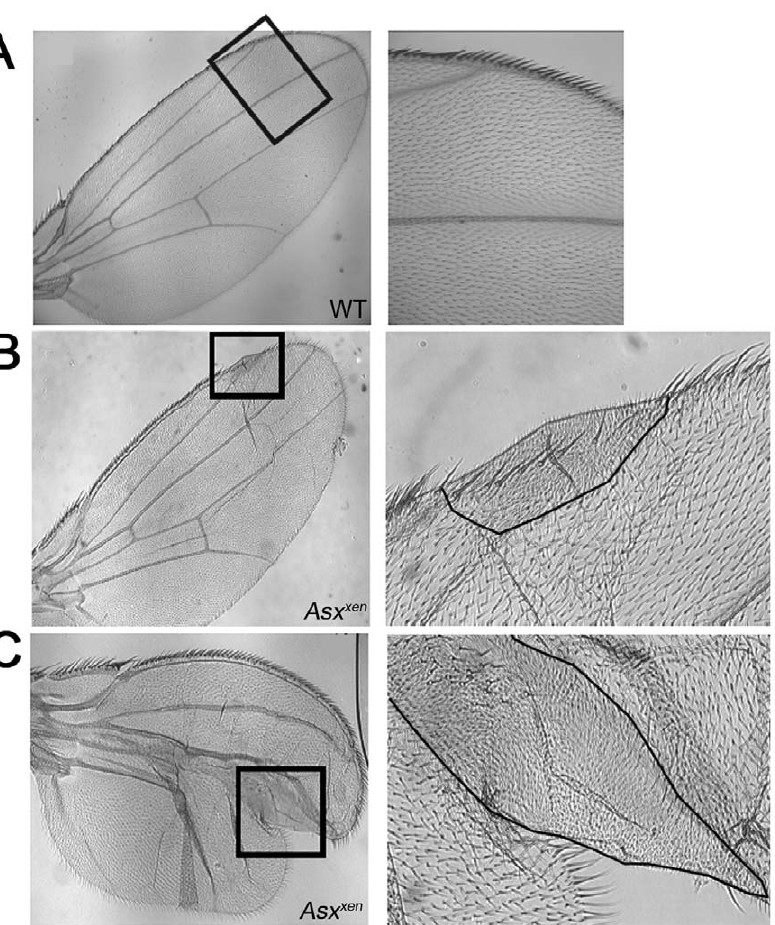
Figure 4. Asx mutant clone adult wings have patches of small cells containing more than one hair. Boxed areas in wing blades are magnified at the right. Small cell clones are outlined in black. A) Wild type. B,C) Wings bearing Asx xen mutant clones with small cells. Clone on edge of wing (B) and dual-lobed wing with small cells in the cleft between the lobes.